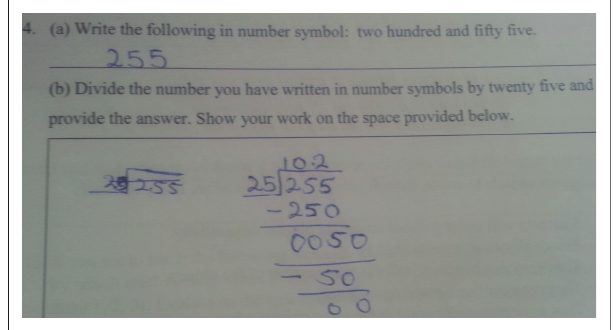
FIGURE 3: Response of Teacher